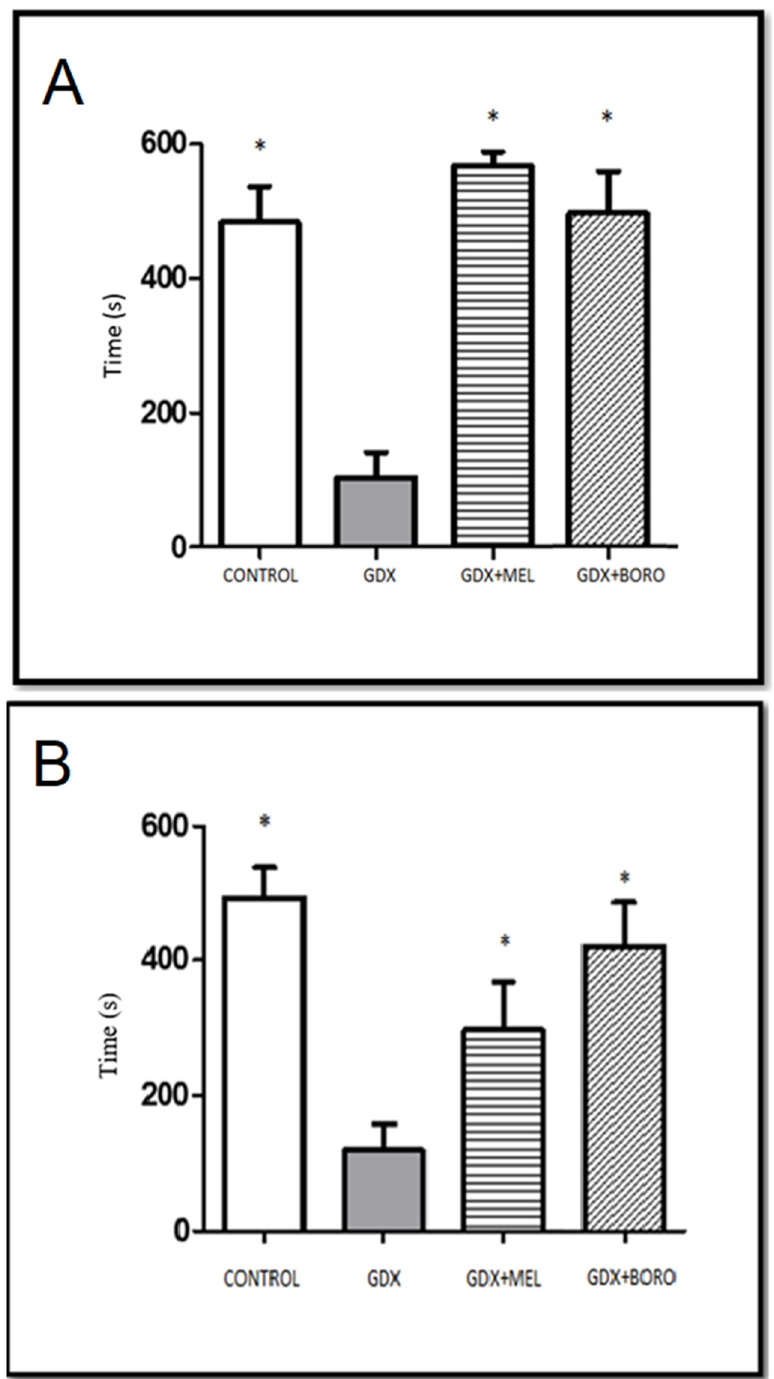
Figure 8. Post-treatment short-term ( A ) and long-term ( B ) memory performance. Results are ex- pressed as mean of time in the safe compartment ± Standard Error of the Mean (SEM, n = 8). * p < 0.05, compared to orchiectomized control group (GDX); MEL, melatonin; BORO, Borolatonin.